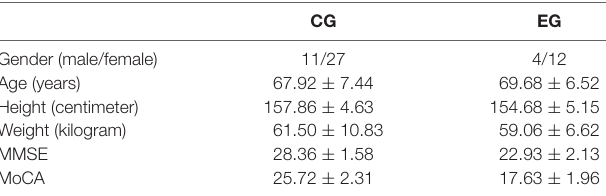
TABLE 1 | Participants’